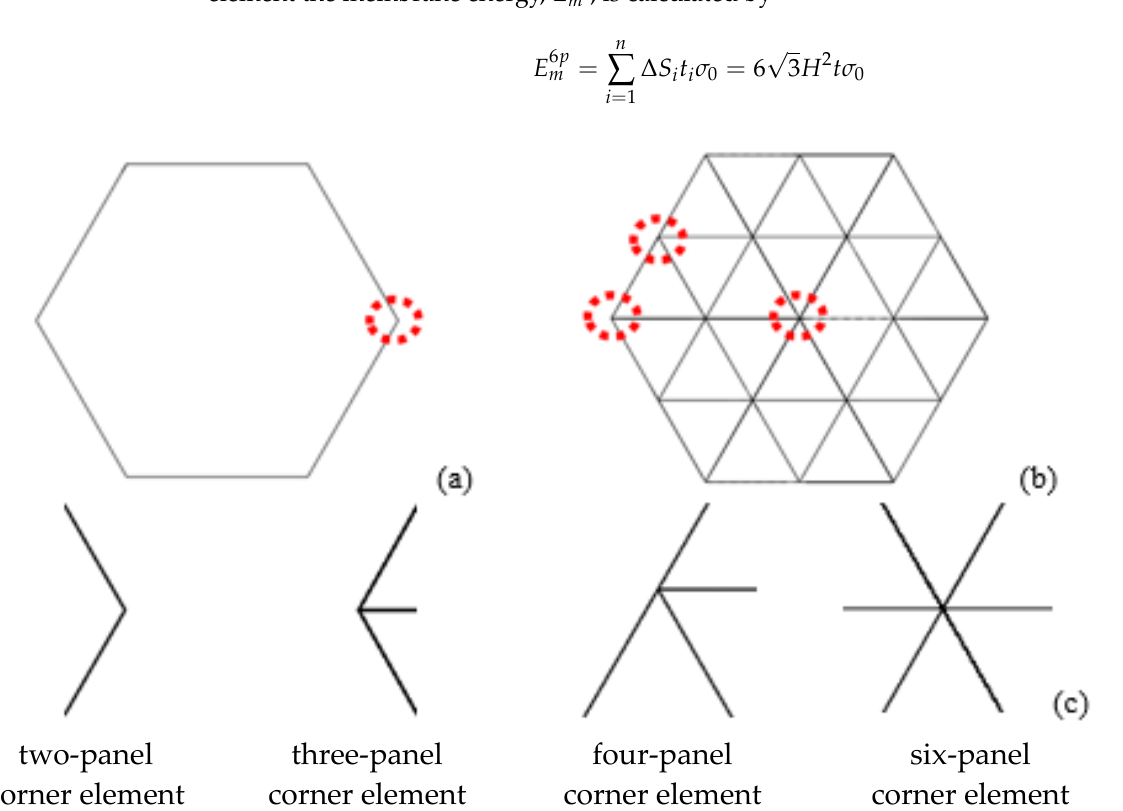
Figure 9. Cross section of ( a ) HST and ( b ) HMT and ( c ) typical angular elements.